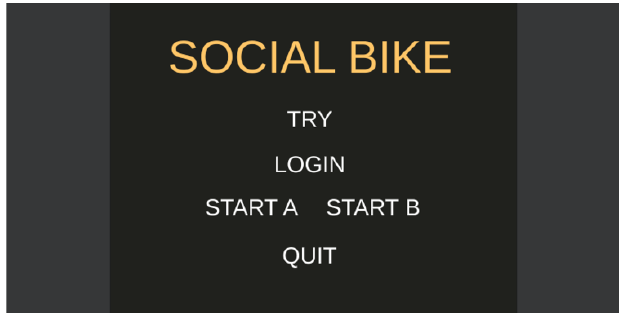
Figure. 7. Start menu of the simulation program.